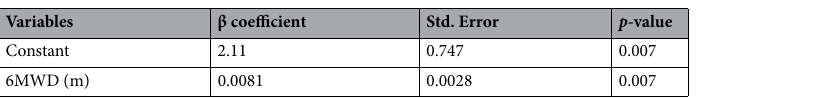
Figure 3. Correlations between exercise capacity and endothelial function. Data are presented as the correlation coefficient (r) and p < 0.05. Relationship between exercise capacity and endothelial function: ( A ) The FMD (mm) was positively associated with the 6MWD; ( B ) The FMD (%) was positively associated with the 6MWD. FMD (mm): absolute values; 6MWD was expressed in meters. The figure was create using SigmaPlot version 11.0, from Systat Software, Inc., San Jose California USA, www.systa tsoft ware.com.